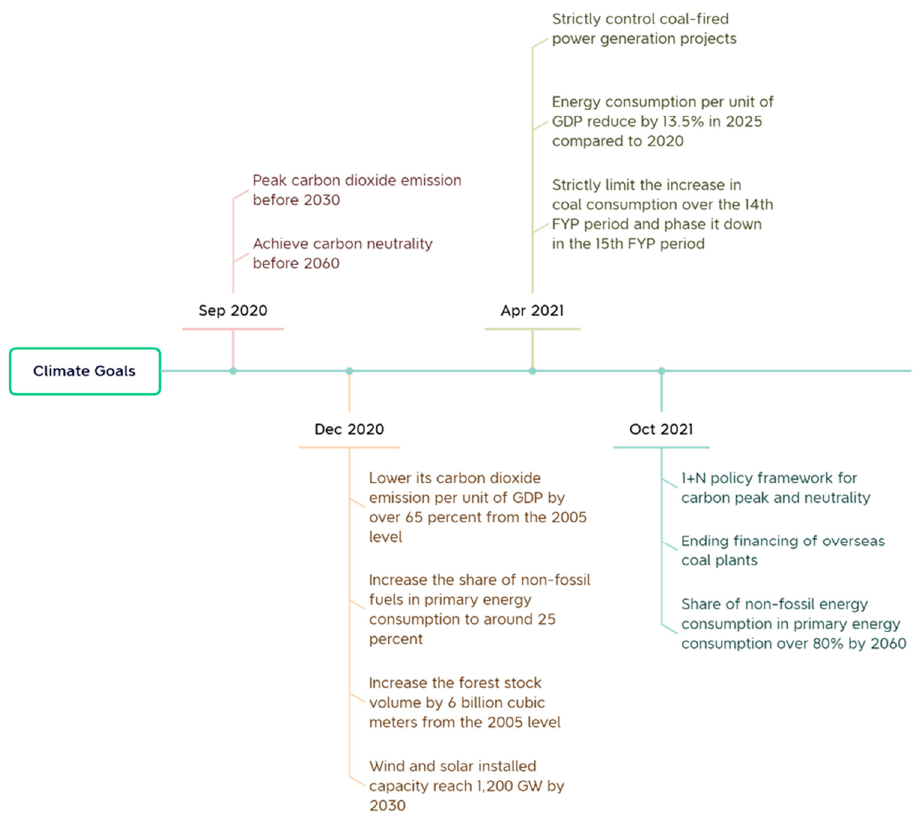
Figure 1. Major climate goals for the Chinese construction sector. Source: authors, based on [8,10,11].